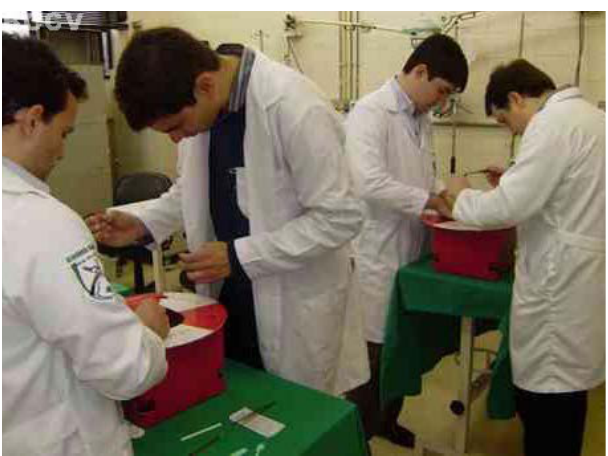
Fig. 2 - Residents in training using Arroyo